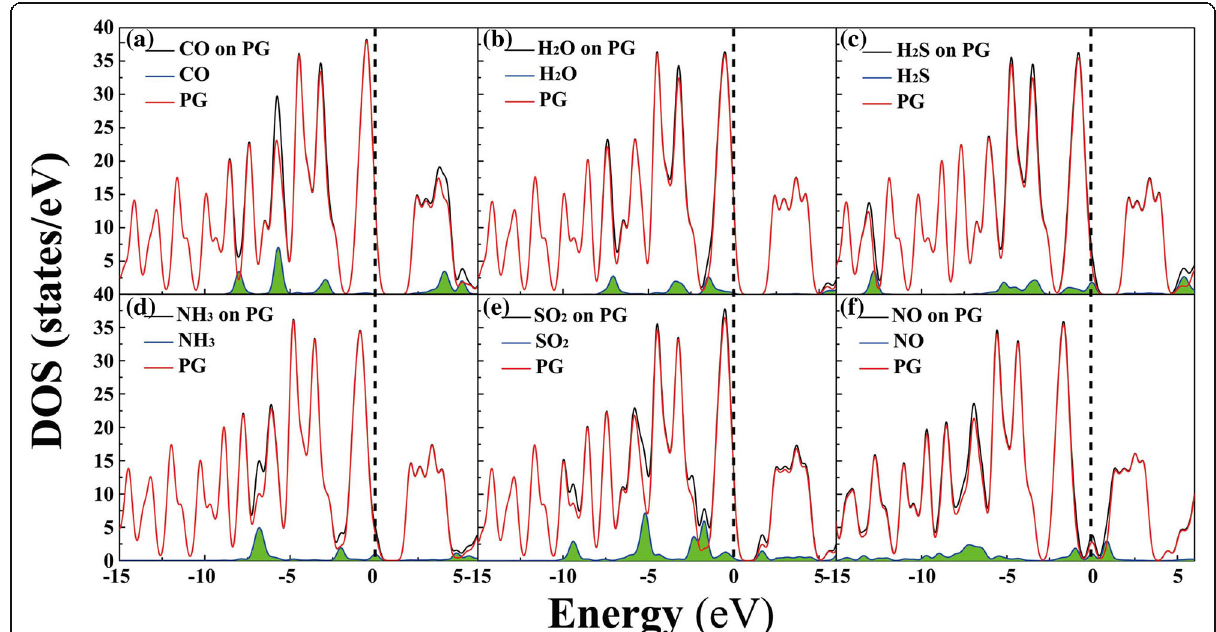
Fig. 3 Total electronic density of states (DOS) for molecule-PG systems (black), and projected DOS for small molecules (blue line with green shadow) and PG (red) in the adsorption system: a CO, b H 2 O, c H 2 S, d NH 3 , e SO 2 , and f NO. The Fermi level is set to zero (see the dash line)